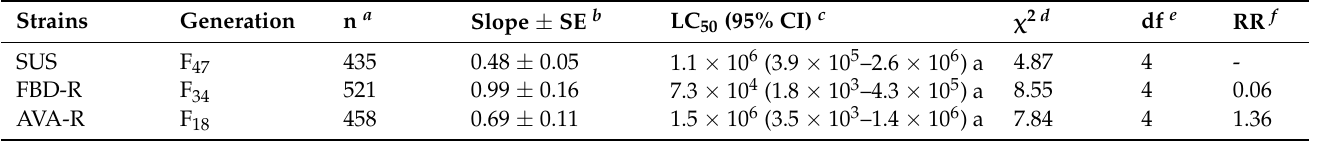
Table 4. Concentration response of susceptible (SUS), flubendiamide (FBD-R), and indoxacarb (AVA-R) resistant strains of Helicoverpa armigera to